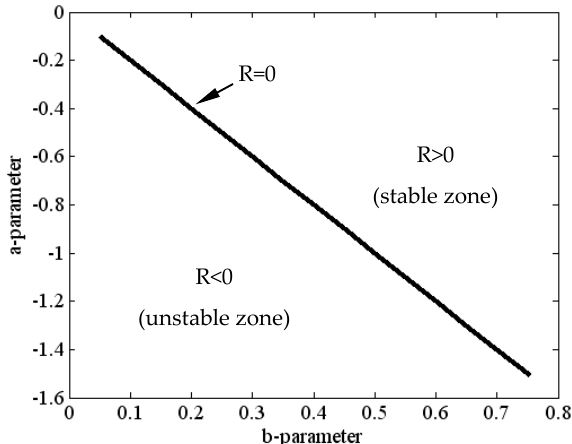
[ ] 755.0,05.0 ∈ b . Here Figure 6. Bifurcation diagram of system (1) at fixed point O O , when and ∈ [ 0.05,0.755 ] . Here we 2 , when and b 2